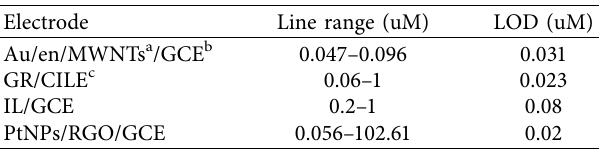
Table 1: Comparison of rutin determination results with different